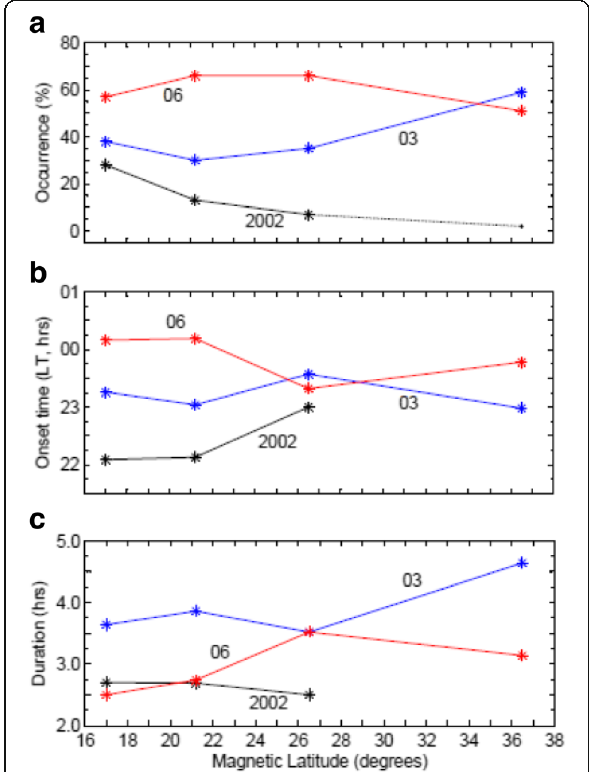
Fig. 6 Latitude variations of a percentage of days of spread-F occurrence, b mean onset time of spread-F, and c mean duration of spread-F in 2002 (black), 2003 (blue) and 2006 (red). The onset time and duration of the lone case at 36.5° N (Wakkanai) in 2002 are not